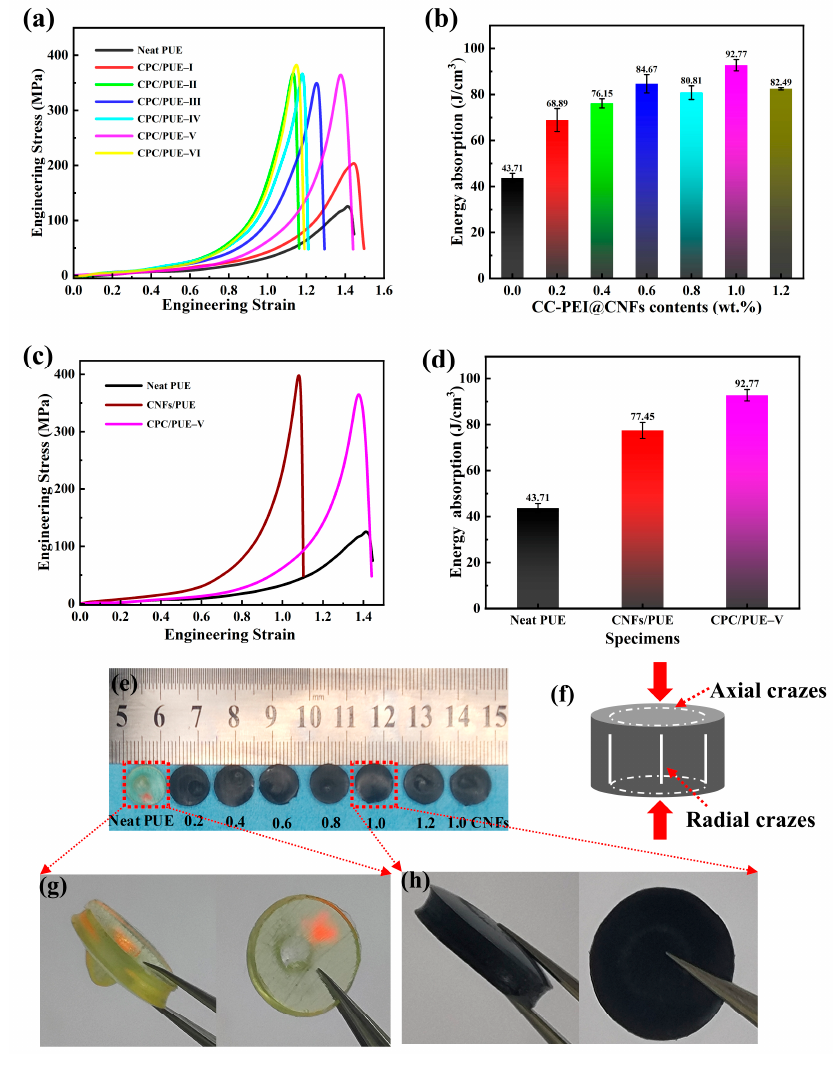
Figure 7. ( a ) Stress-strain curves of PUE composites tested by SHPB, ( b ) energy absorption of PUE composites, ( c ) stress-strain curves of the neat PUE, 1.0 wt.% CNFs/PUE and CPC/PUE- Ⅴ , ( d ) energy absorption capacity of the neat PUE, 1.0 wt.%CNFs/PUE and CPC/PUE- Ⅴ , ( e ) pictures of PUE and CPC/PUE after SHPB test. ( f ) Axial and radial failure of samples under high-speed impact. ( g ) Enlarged images of the neat PUE. ( h ) Enlarged images of CPC/PUE- Ⅴ .